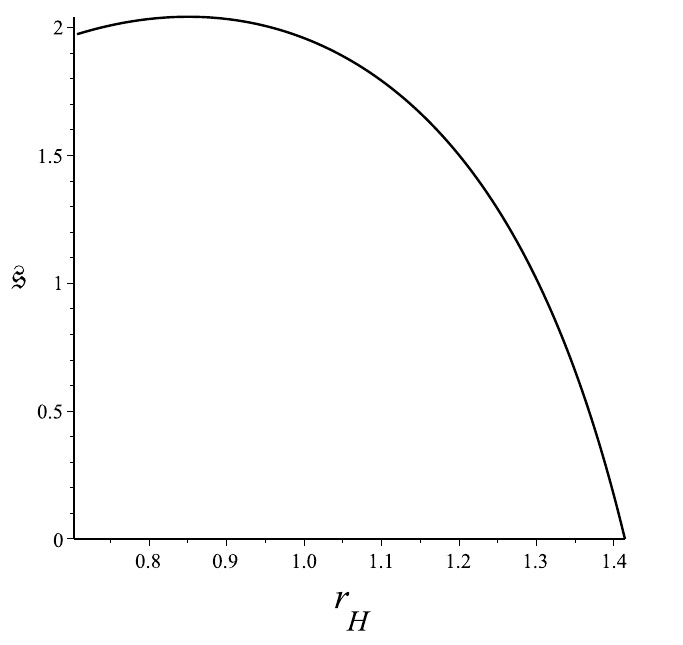
Figure 9 . Specific entropy of an AdS 5 -Kerr black hole with fixed temperature equal to the smallest possible AdS 5 -Schwarzschild temperature √ 2 /π The domain is the physical one,